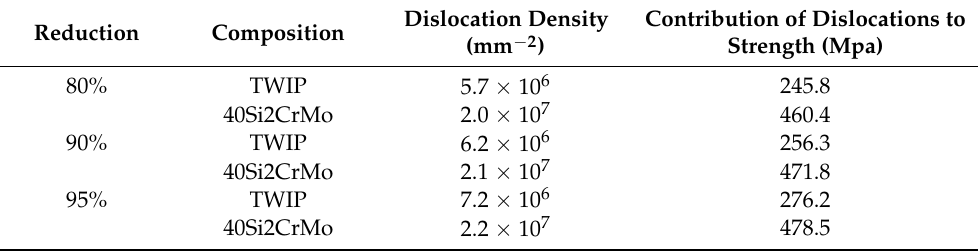
Table 5. The full width at half maximum (FWHM), dislocation densities, and contribution of dislocation to strength for multilayer TWIP/40Si2CrMo steels with different warm rolling reductions. Dislocation Density Contribution of Dislocations Reduction Composition (mm − 2 )